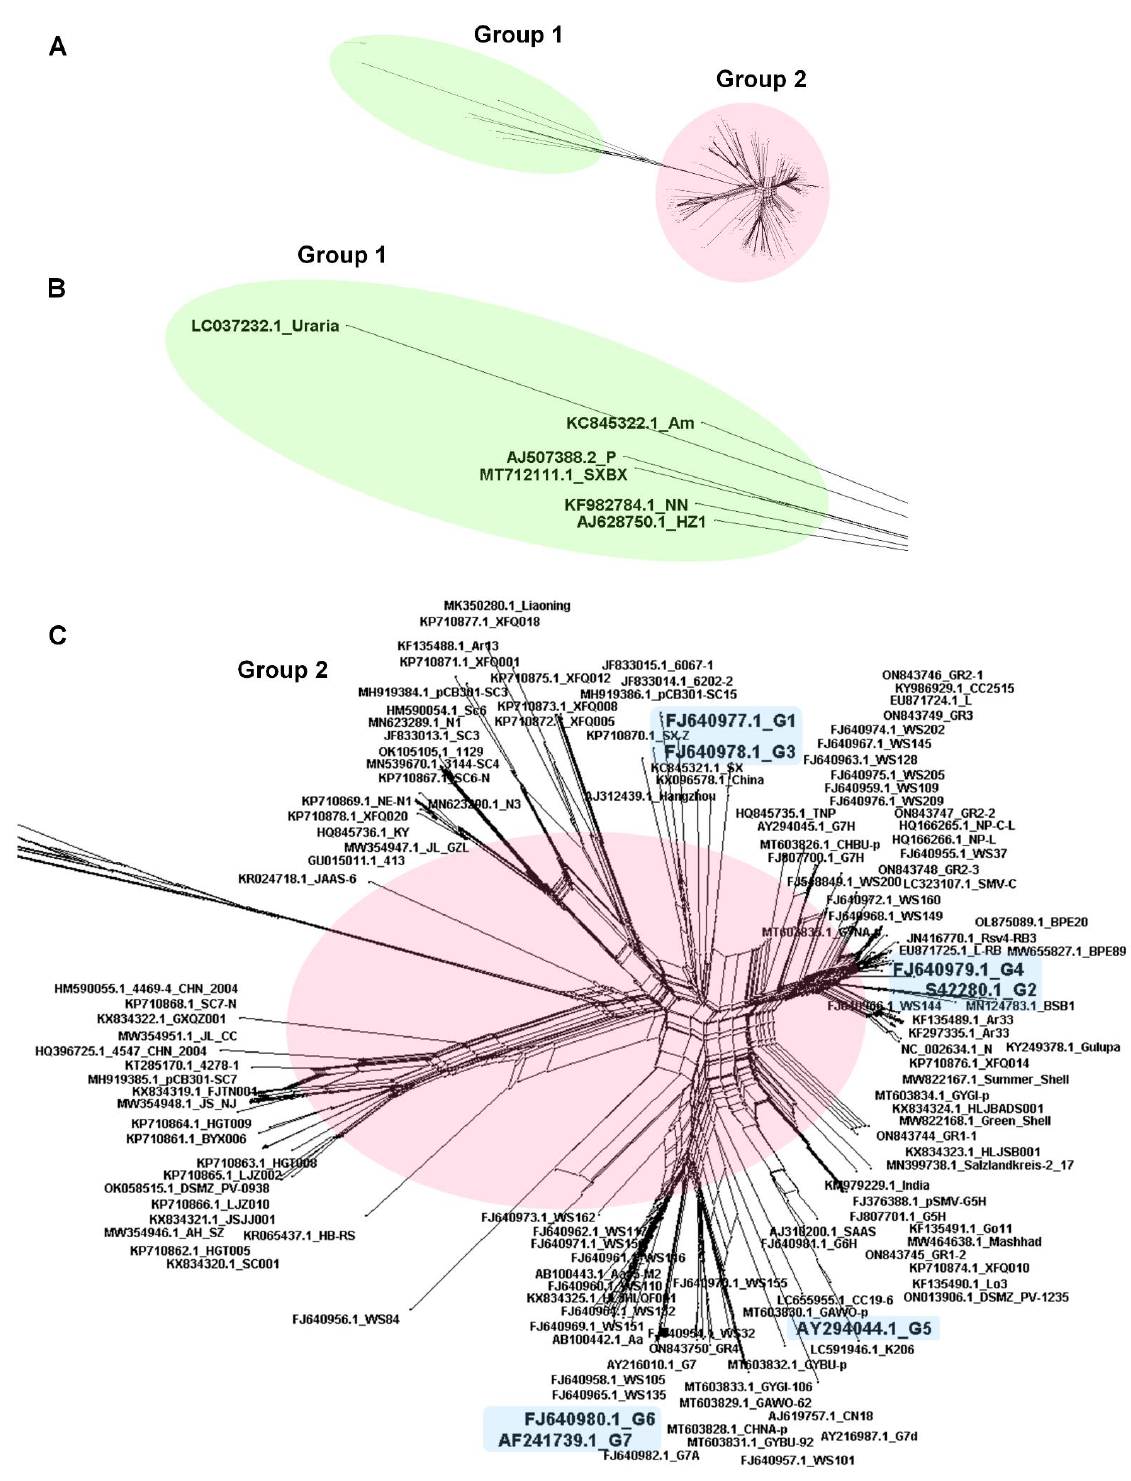
Figure 4. Phylogenetic network tree of 143 SMV genomes. The network tree was rooted using the complete genome sequences of 143 SMV genomes and contains 2 groups (Group 1 and Group 2) of SMV genomes ( A ). Group 1 is shown in a green oval in the network tree and was then further magnified ( B ). Group 2 is shown in a pink oval in the network and then was further magnified ( C ) The seven known SMV strains (G1–G7) are shown in the light blue colored box. The accession numbers and isolate names are also indicated. Using the nexus alignment file in the supplemental file S1, the network tree can be visualized in the SplitsTree